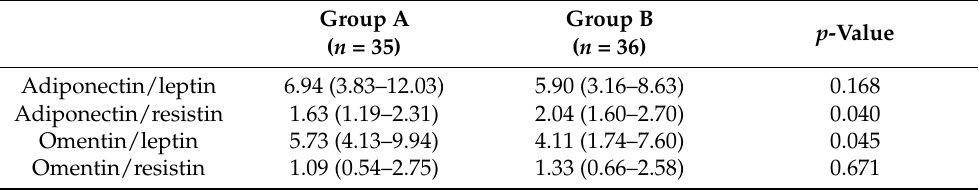
Table 3. The ratios of anti-inflammatory adipokines (adiponectin, omentin) to pro-inflammatory adipokines (leptin, resistin) in two studied groups of children ( n = 71). Group A